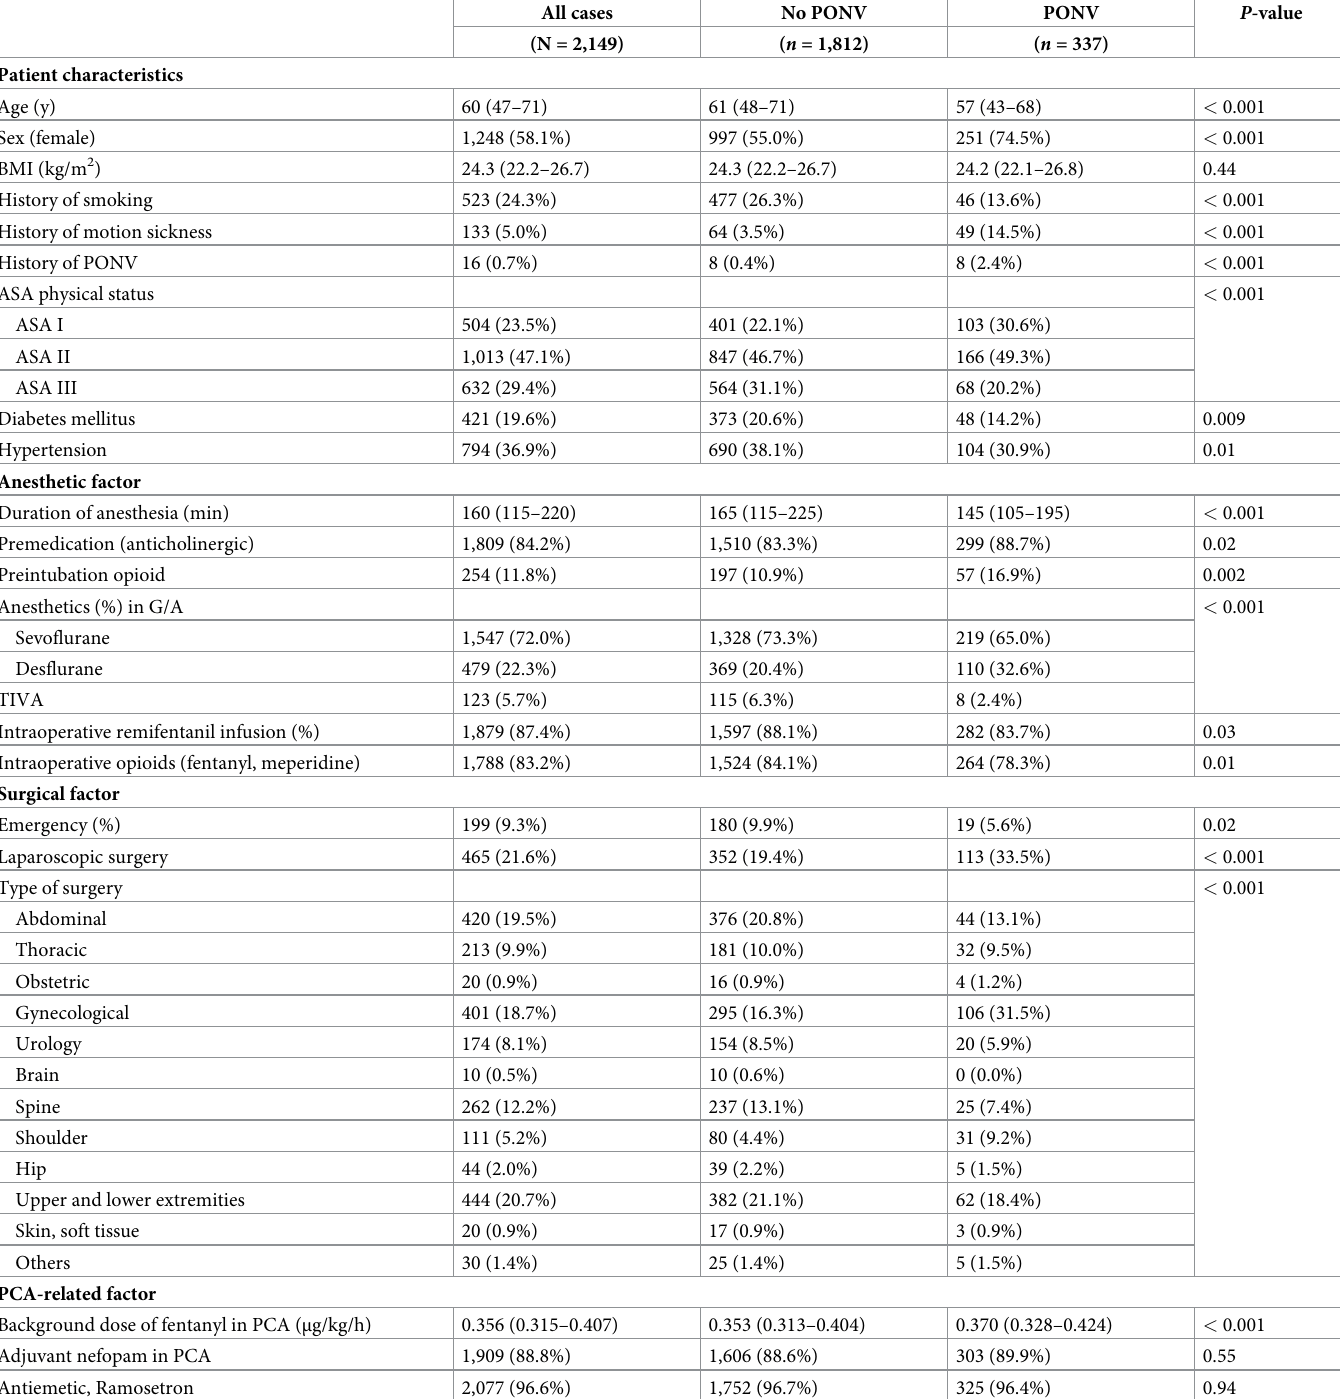
Table 2. Dataset